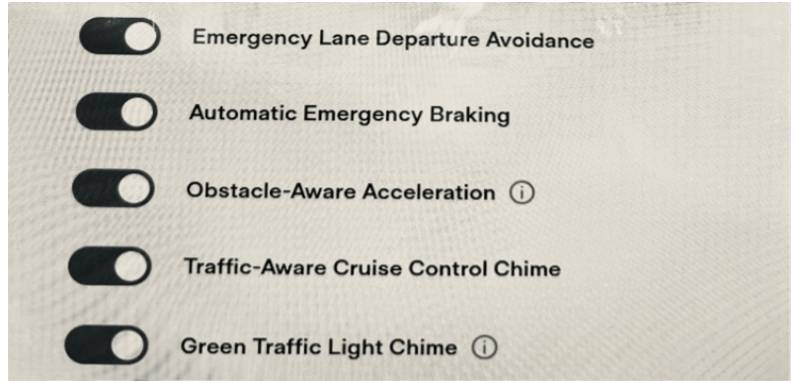
Figure 4. Autopilot section of Tesla